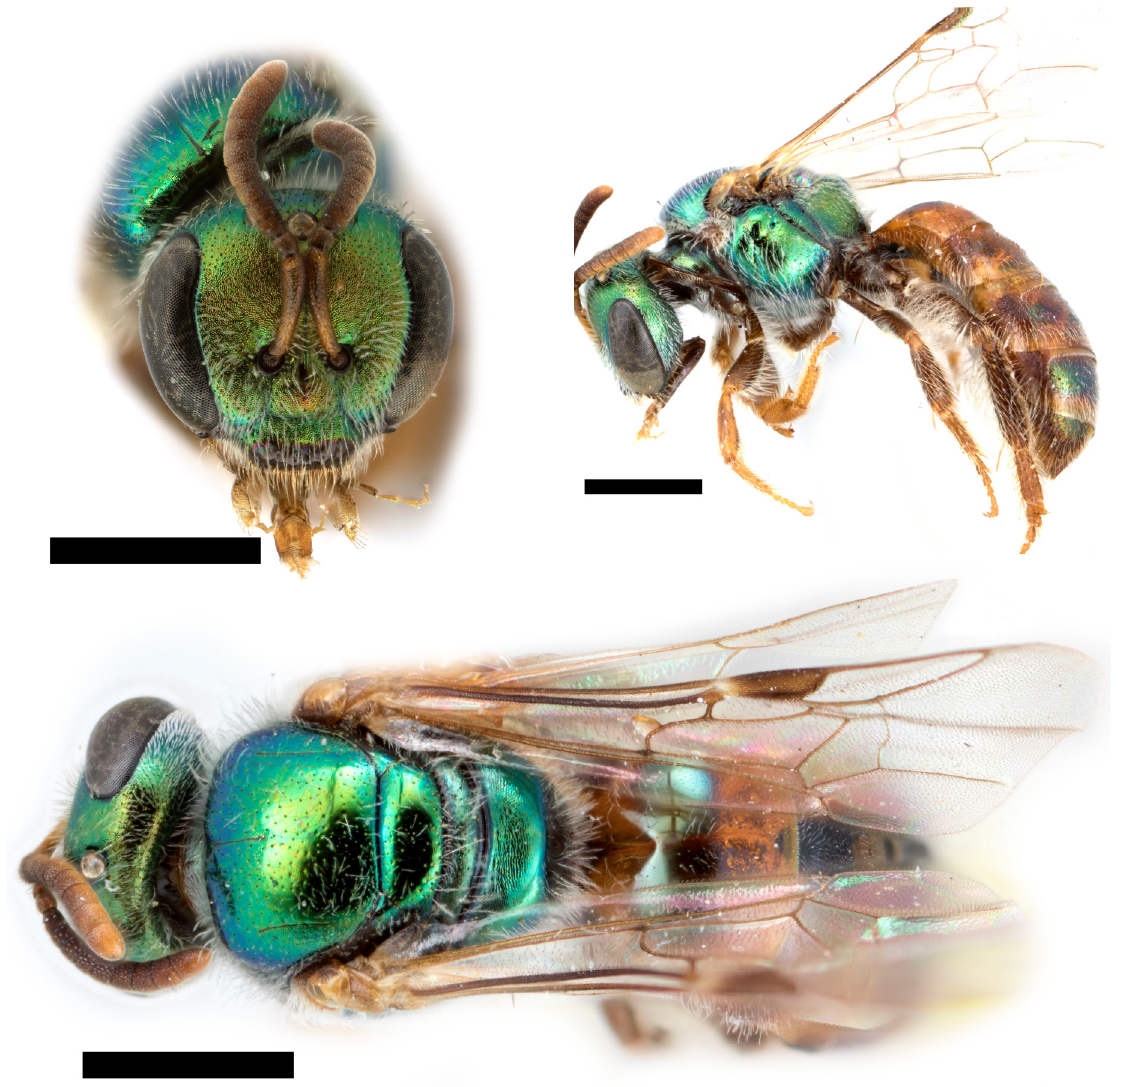
Fig. 27. Lasioglossum rufopanticis (Engel, 2001), ♀. A . Face. B . Lateral habitus. C . Dorsal habitus. Scale bars = 1